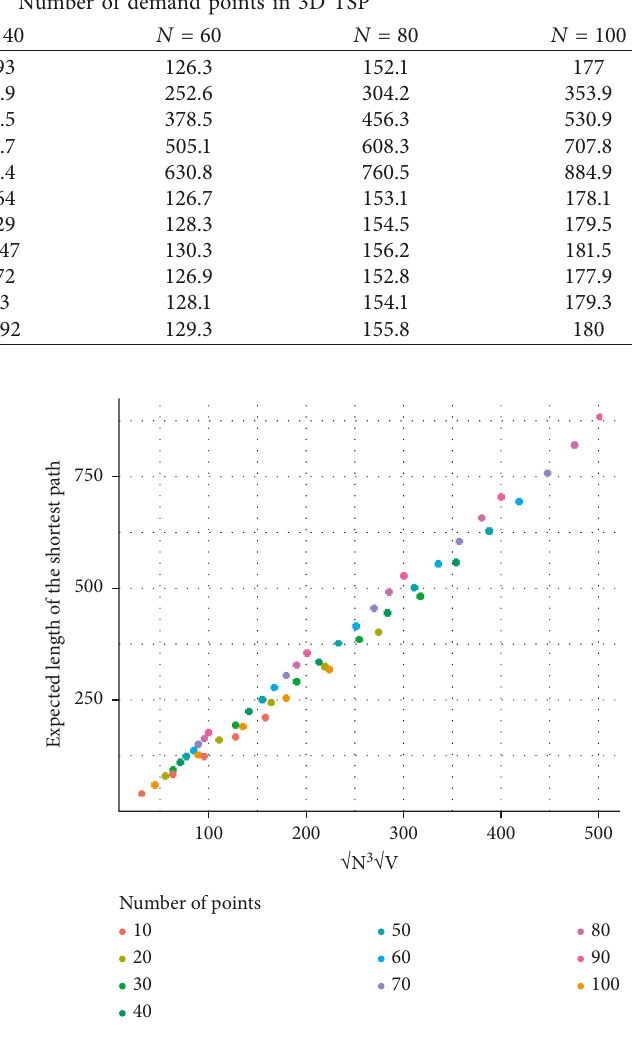
Figure 6: Scatterplot of the expected length of the shortest path and N √ V 3 √ ( s 1 1 ,s 2 (cid:31) (cid:31) (cid:31)(cid:31) (cid:31)(cid:31)